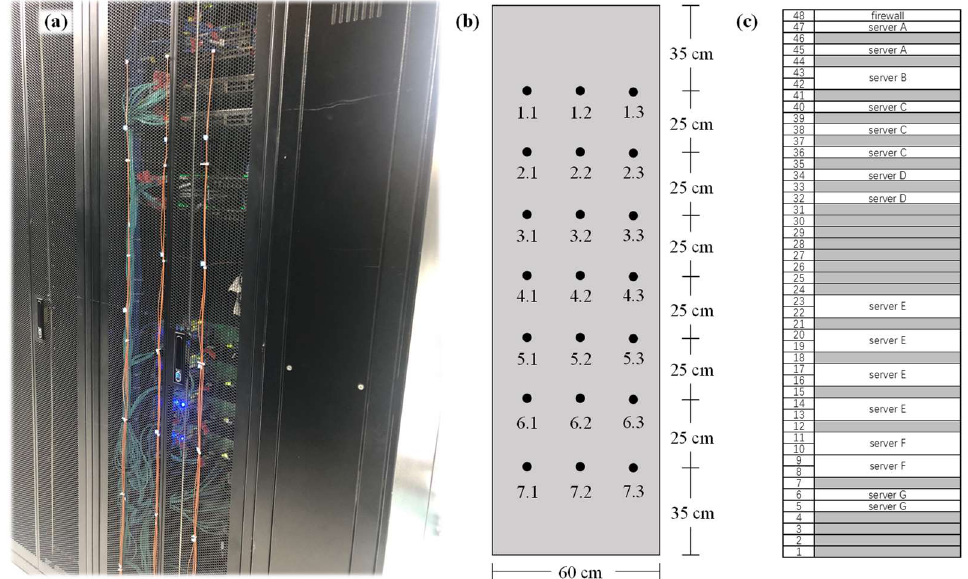
Figure 6. Field experiments figures: ( a ) experiment setup photo of rear door; ( b ) thermocouple positions on front and rear doors; ( c ) servers on the tested rack.